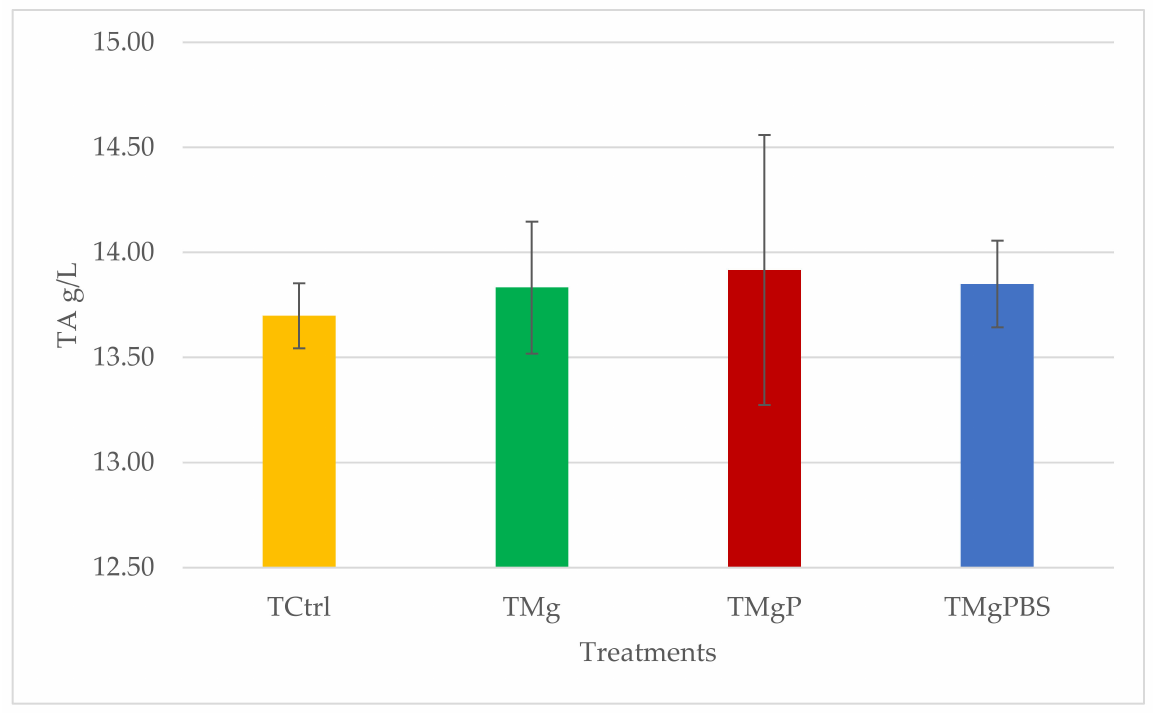
Figure 7. Total acidity (TA) in the must by treatment. (TCtrl—NPK, TMg—NPK + Agromag (6% MgO), TMgP—NPK + Agromag + Fosforo (30% P 2 O 5 ) and TMgPBS—NPK + Agromag + Fosforo + Bio Prot), Error bars indicate standard deviation ( n = 6).